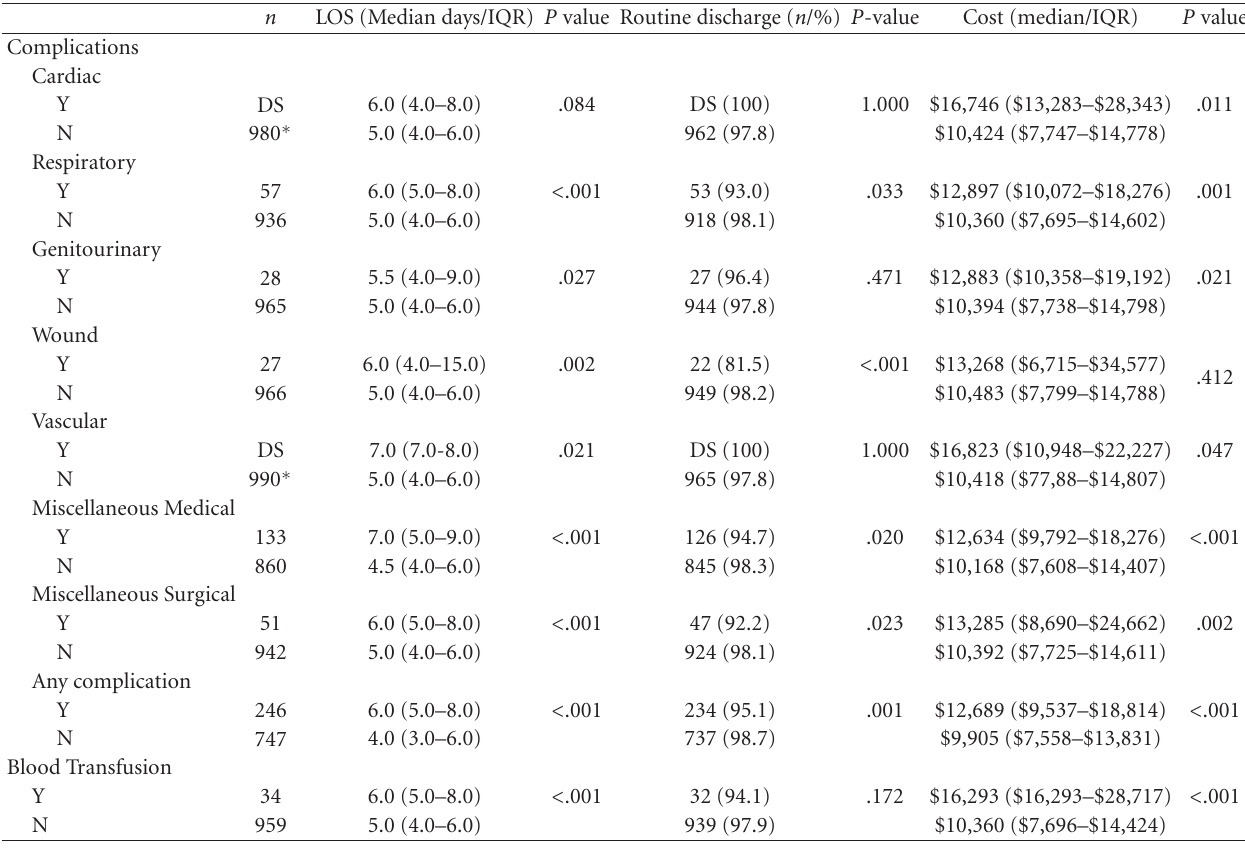
Table 4: Length of stay, discharge status, and costs by clinical outcomes.